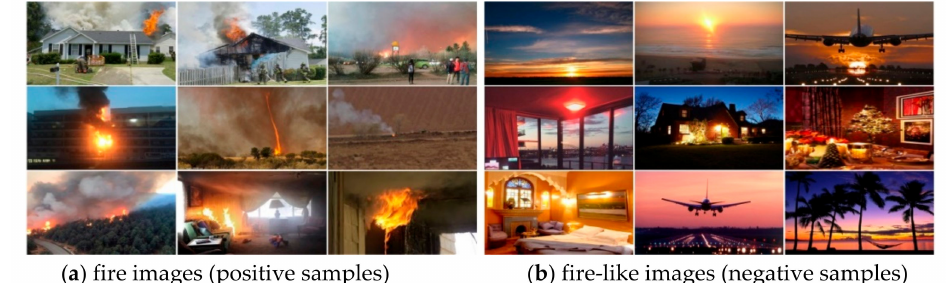
Figure 4. Training dataset.